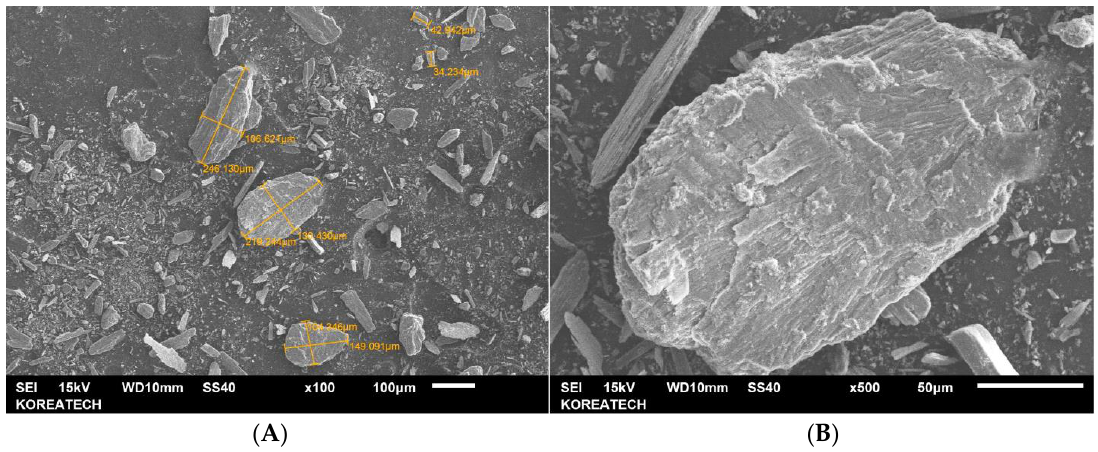
Figure 11. Scanning electron microscope (SEM) micrographs of oyster shell powder (OSP) obtained with dry ball grinding at different magnifications ×100 ( A ) and × 500 ( B ).